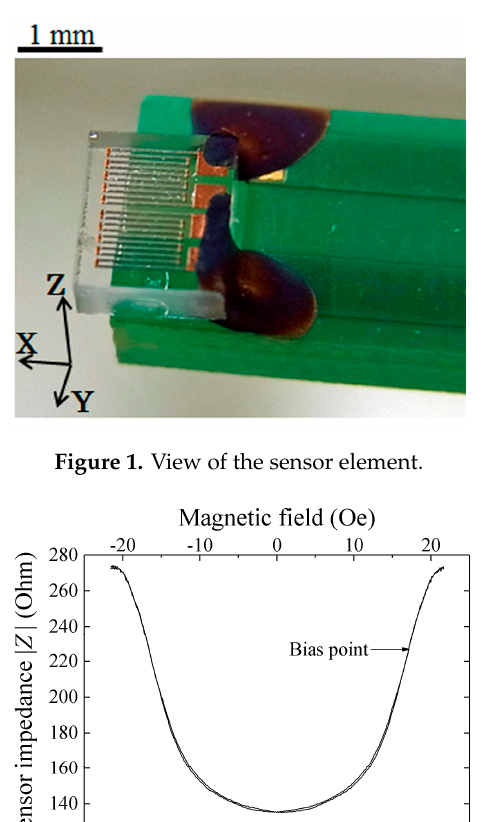
Figure 1. View of the sensor element.